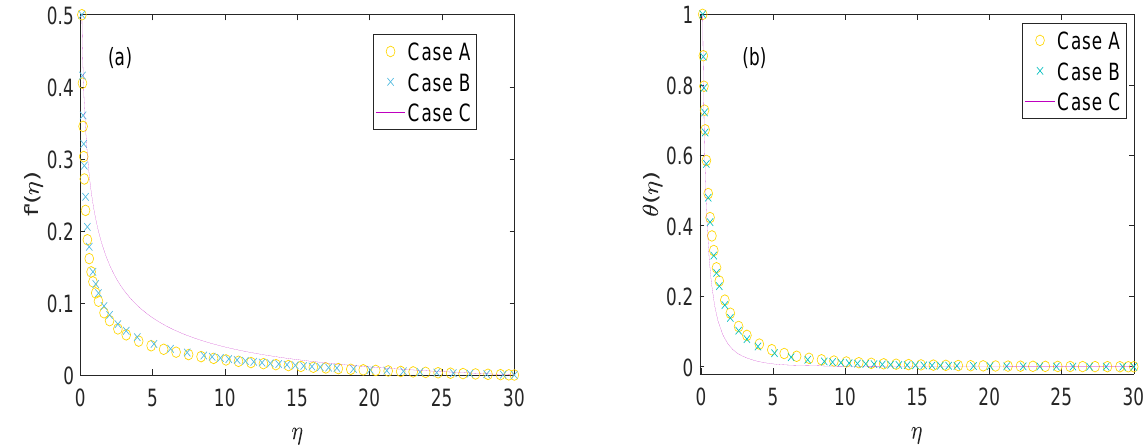
Figure 2. Comparison of velocity and temperature profiles for Case A (Exponential temperature dependent viscosity), Case B (Inversely linear temperature dependent viscosity) and constant fluid properties when the parameters are fixed at m = 0.1, Pr = 5, λ = 1, (cid:101) = 0.5, θ e = − 0.37 and θ w = 1.27. Part ( a ) shows function f (cid:48) , while the function θ is plotted in part ( b ).